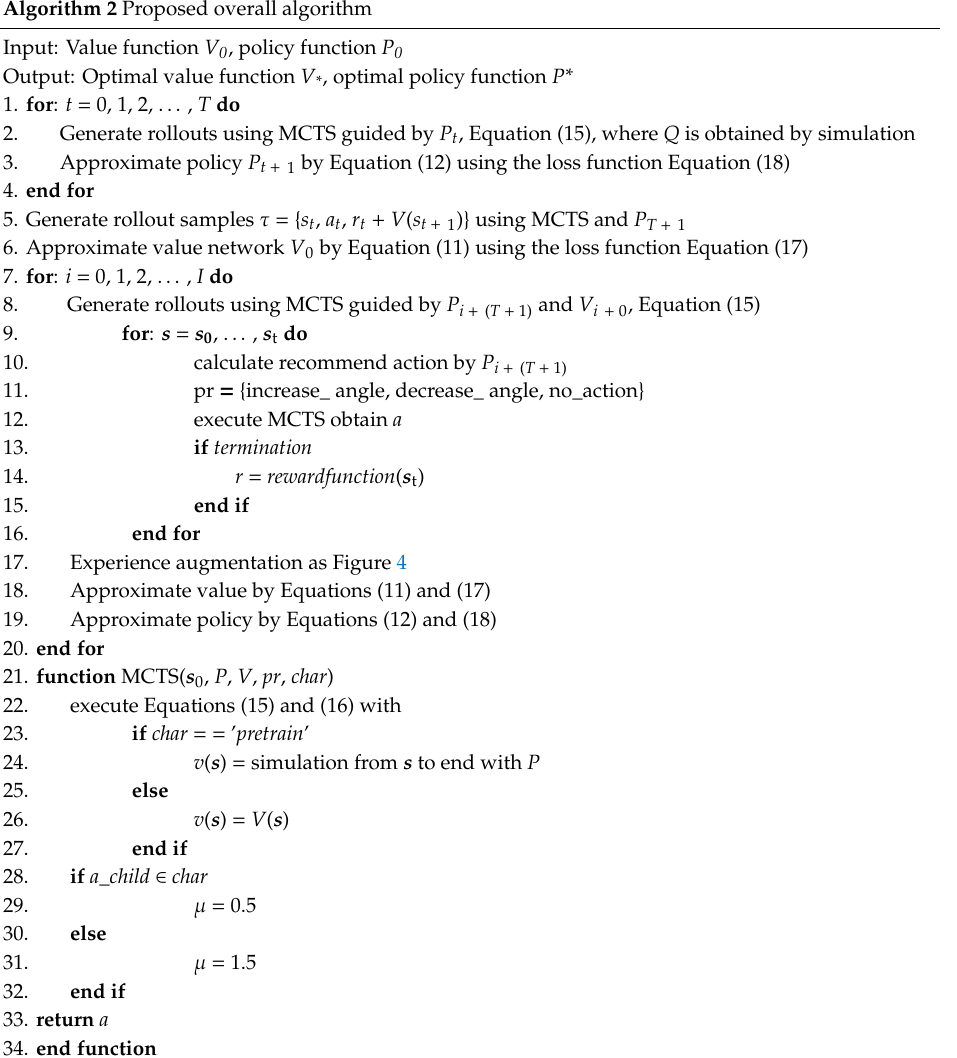
Algorithm 2 Proposed overall